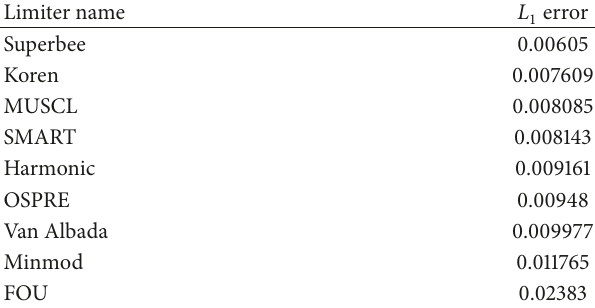
Table 3: Order of accuracy for the TVD